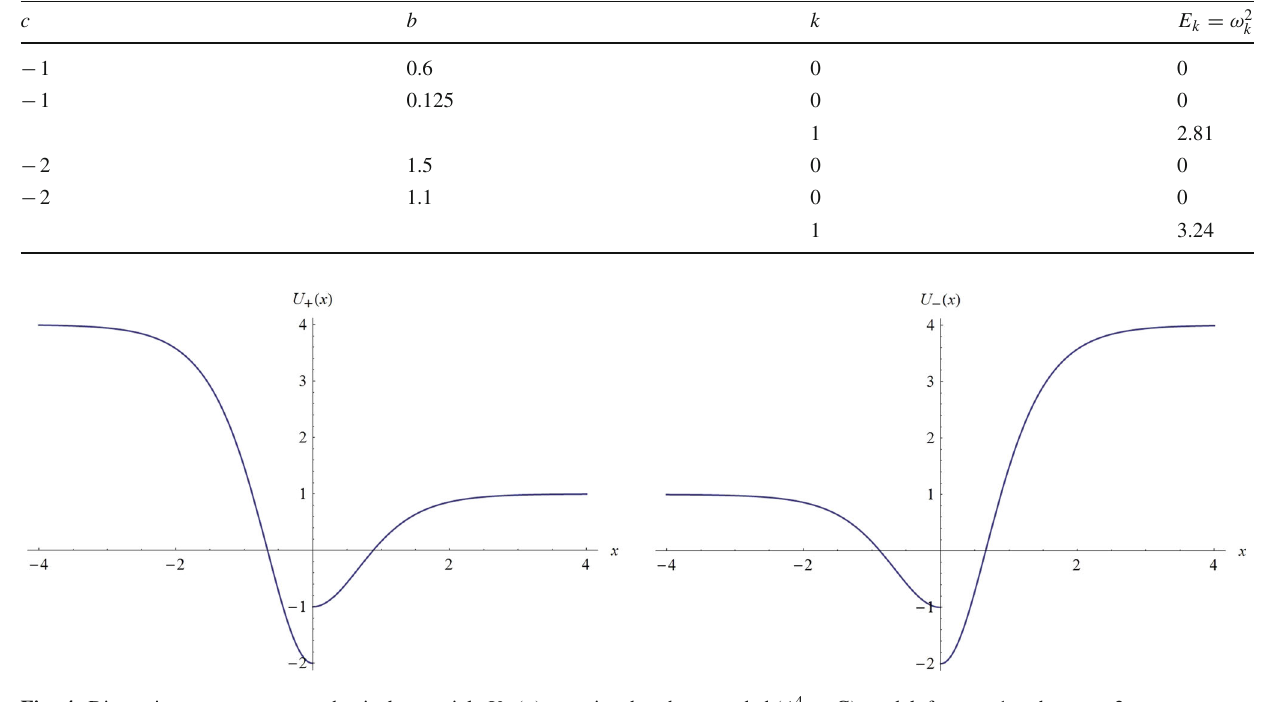
Fig. 4 Discontinuous quantum-mechanical potentials U ± ( x ) associated to the extended ( φ 4 + sG) model, for α = 1 and a 2 = − 2 a